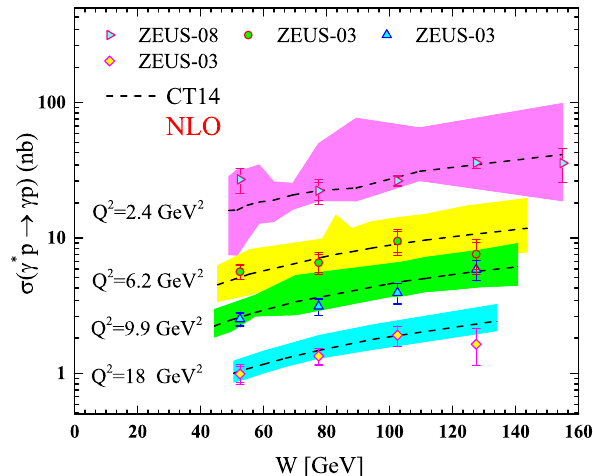
Fig. 10 The DVCS γ ∗ p → γ p cross section as a function of W for selected values of Q 2 = 2 . 4, 6 . 2, 9 . 9, and 18 GeV 2 . The NLO pQCD predictionsbasedontheGPDmodelofEq.(1)alongwiththeCT14[67] PDFs are compared to the 2003 and 2008 ZEUS data